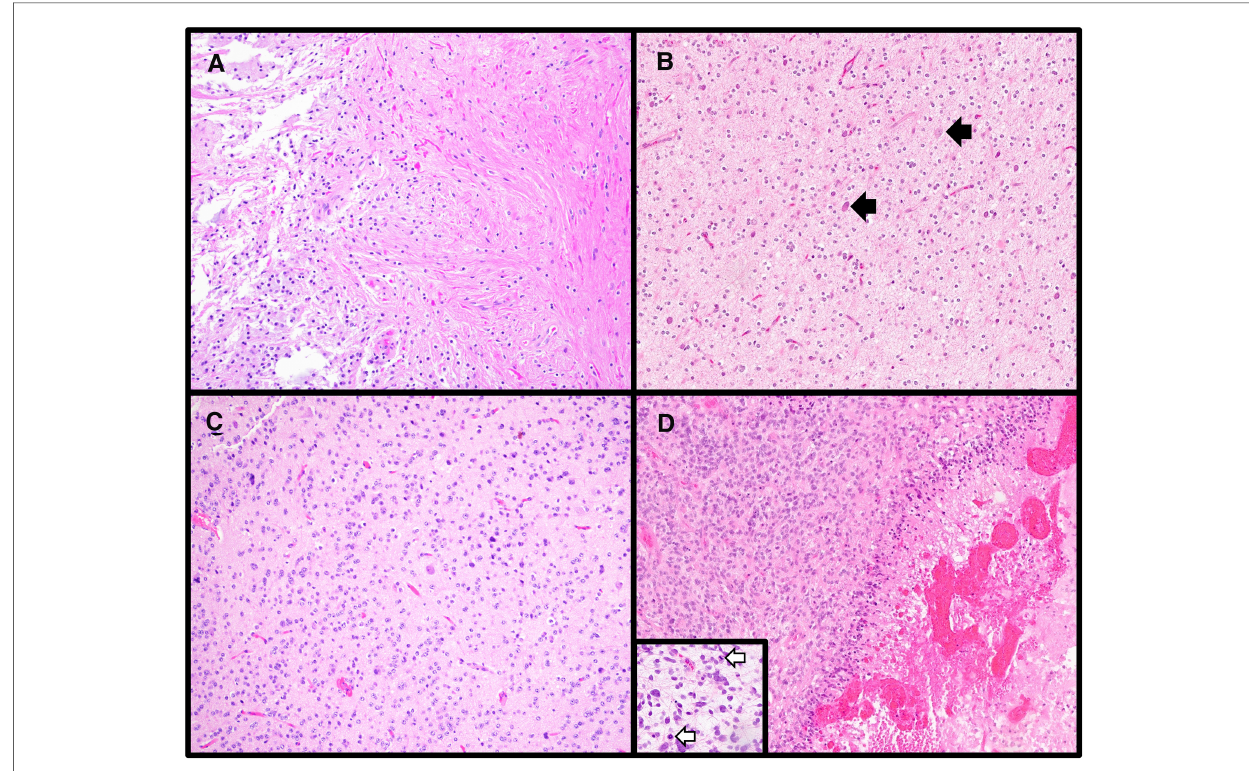
FIGURE 1 Varied histologic features of central nervous system tumors. ( A ) Pilocytic astrocytoma is a circumscribed astrocytoma with characteristic features including alternating compact (right side of image) and loose (left side of image) regions, cells with elongated (piloid processes), and Rosenthal fi bers and eosinophilic granular bodies (H&E stain, 100× magni fi cation). ( B ) Many low-grade glial/glioneuronal tumors share overlapping histologic features, including the presence of oligodendroglial-like cells as was seen in this case. A few clusters of tumor cells as well as scattered neurons (black arrows) were present. The histologic differential included multiple low-grade entities, therefore a preliminary diagnosis of low-grade glial/glioneuronal tumor pending molecular workup was rendered. The tumor was subsequently found to have an internal tandem duplication involving FGFR1 , consistent with a diagnosis of dysembryoplastic neuroepithelial tumor (H&E stain, 100× magni fi cation). ( C ) Diffuse glioneuronal tumor with oligodendroglioma-like features and nuclear clusters is a newly described entity for which molecular con fi rmation of the diagnosis via methylation pro fi ling is required (H&E stain, 100× magni fi cation). ( D ) High-grade gliomas can have varied morphologies; however, high mitotic rates (mitoses highlighted by white arrows in the inset) and focal necrosis (right side of the main image) are frequently encountered in these tumors (Diffuse midline gliomas, H3 K27-altered, H&E stains, main image 100× magni fi cation, inset 200× magni fi